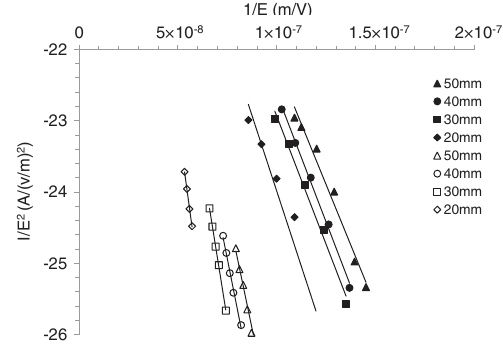
FIG. 5. Example of Fowler-Nordheim line plots for large-grain niobium before (solid symbols) and after (open symbols) kryp- ton processing.